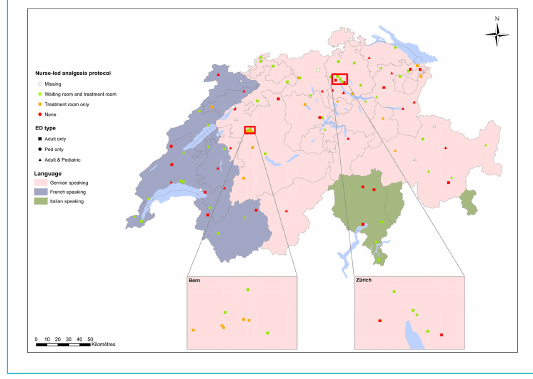
Figure 2: Emergency departments (EDs) stratified by nurse-initiat- ed analgesia protocol and type of patient.